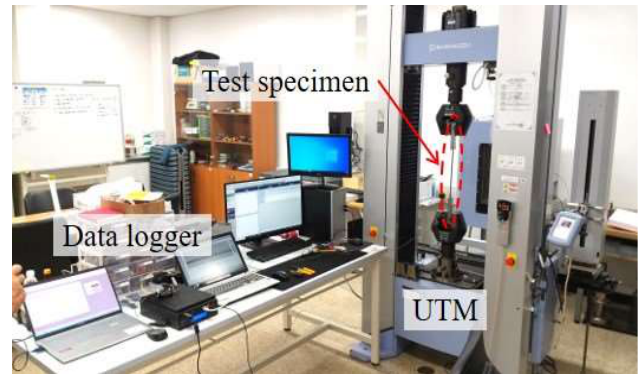
Figure 1. Tensile test set-up for the FRP strip.